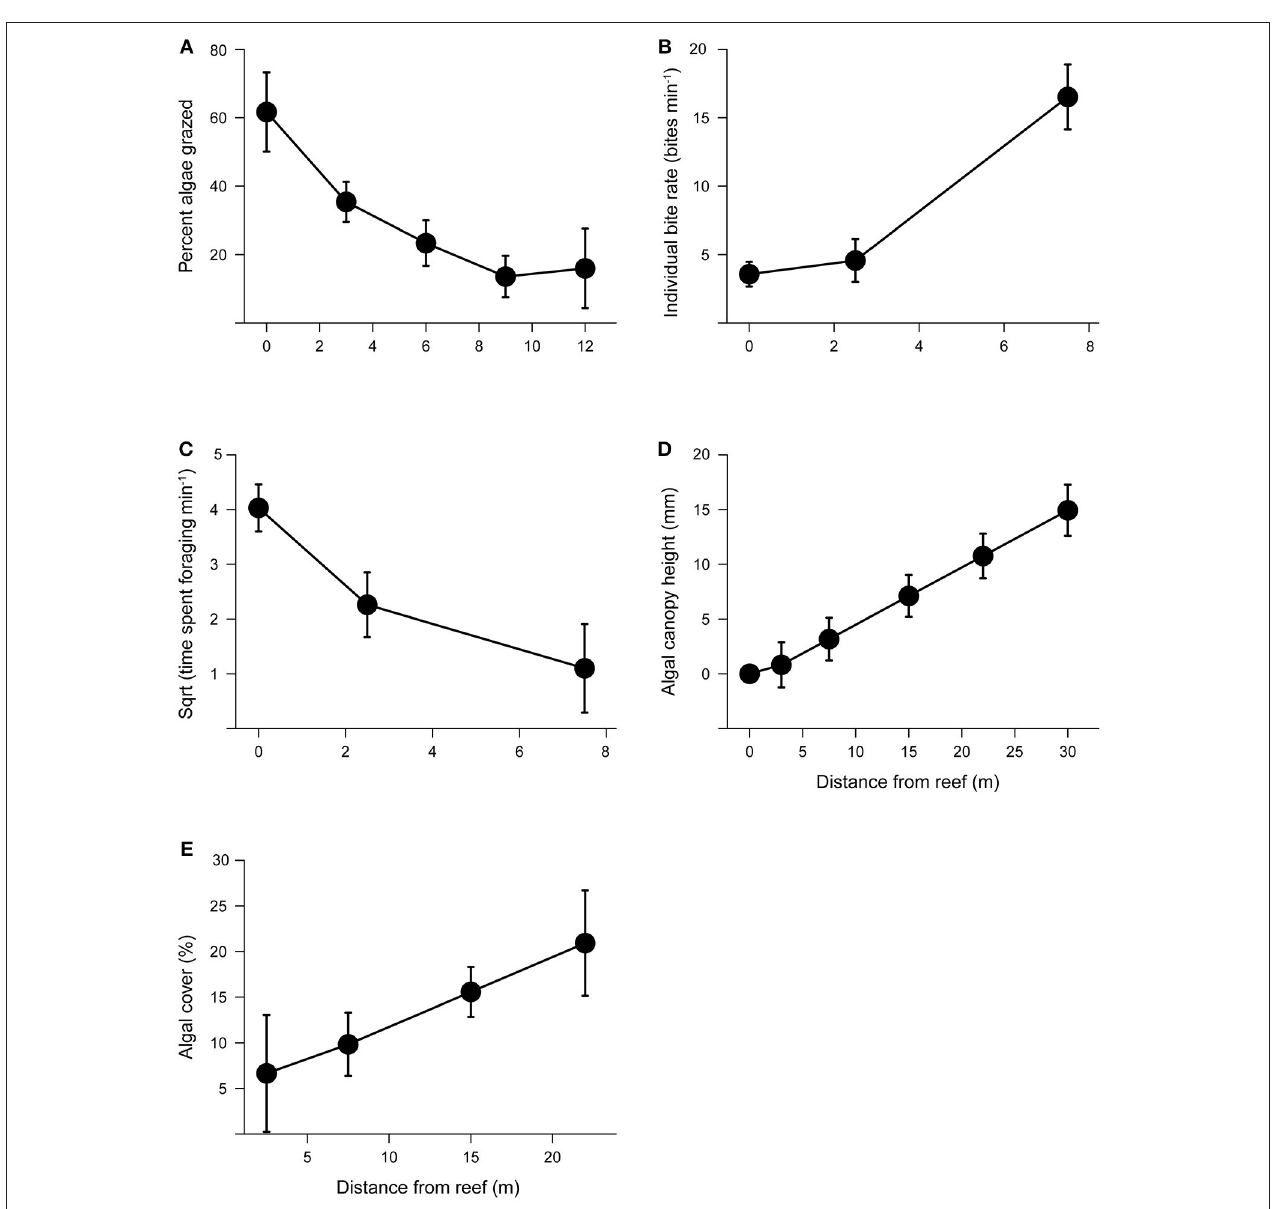
FIGURE 3 | Grazing intensity and its effects on algal growth with increasing distance from patch reefs. (A) Mean percent algae removed ( ± s.e.) with increasing distance from patch reef following 72h grazing assays. (B) Mean individual bite rates ( ± s.e.) by herbivores with increasing distance from patch reefs. We did not observe any herbivorous fish foraging at distance > 7.5m from the reef edge. (C) Mean herbivore foraging time ( ± s.e.) with increasing distance from patch reefs. (D) Mean algal canopy height ( ± s.e.) with increasing distance from the patch reef. (E) Mean percent algal cover ( ± s.e.) with increasing distance from the patch